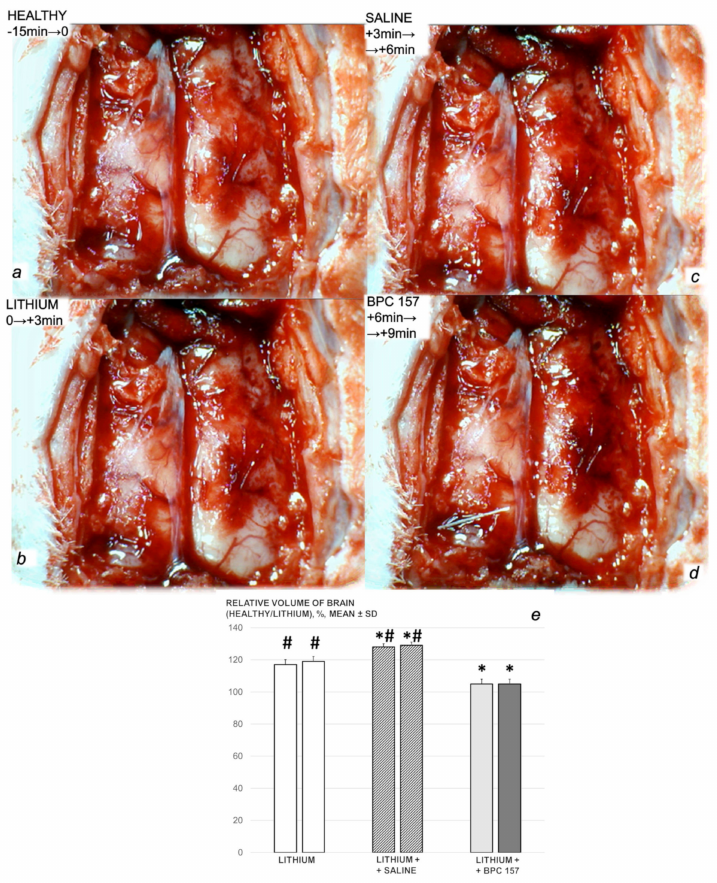
Figure 10. Time-line of the brain swelling and brain swelling counteraction. Brain swelling gross in vivo presentation, and lithium administration at time 0. ( a ) Before the lithium sulphate admin- istration (time 0), presentation of the brain in the healthy rat at 15 min after calvariectomy (period − 15 min → 0). ( b ) Swelling progression immediately after rat received lithium administration (period 0 → +3 min). ( c ) Further swelling progression immediately after lithium-treated rats received saline therapy. ( d ) Counteracted brain swelling after lithium-treated rats received BPC 157 therapy. ( e ) Relative volume of brain swelling, volume healthy/volume after lithium, %, in the lithium-treated rats (white bars, lithium only), in the lithium-treated rats that received saline (5 mL/kg intraperi- toneally (dashed bars), and finally, in the lithium-treated rats after receiving after saline, an additional application of BPC 157 10 µ g/kg (light gray bars) or 10 ng/kg (dark gray bars) given intraperitoneally. Estimated periods were 3 min for the lithium administration, and subsequent administration of saline, and BPC 157. Six rats/group/interval. Means ± SD, * p < 0.05, at least vs. control (lithium). # p < 0.05, at least vs.